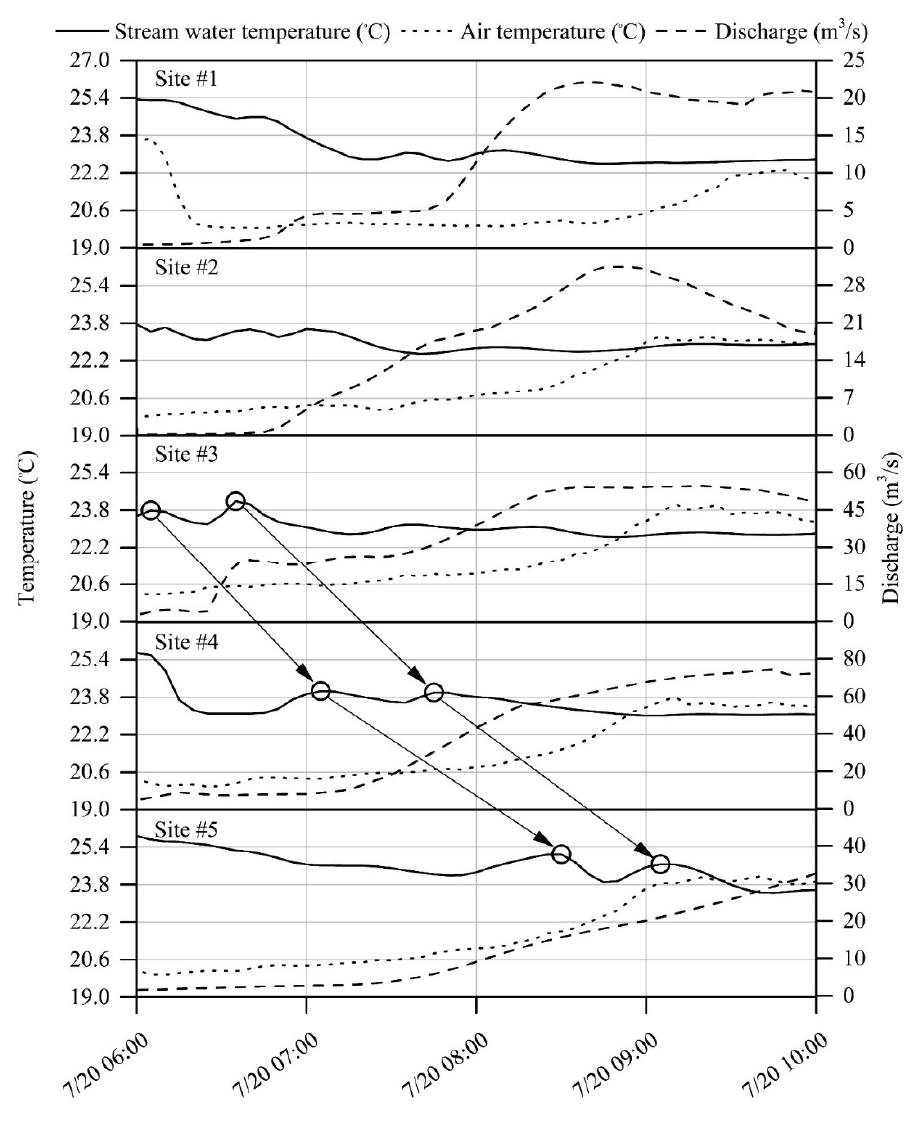
Figure 4. Stream water temperature surges sensed at gauging sites in Hinkson Creek following a summer thunderstorm near sunset during summer 2011. The black circles mark the peak T w surges and the arrows track the T w surges downstream from sites #3 through